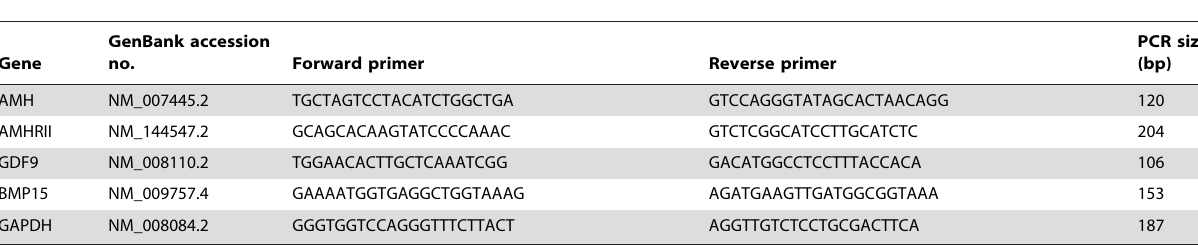
Table 1. Real-time PCR primer sequences.